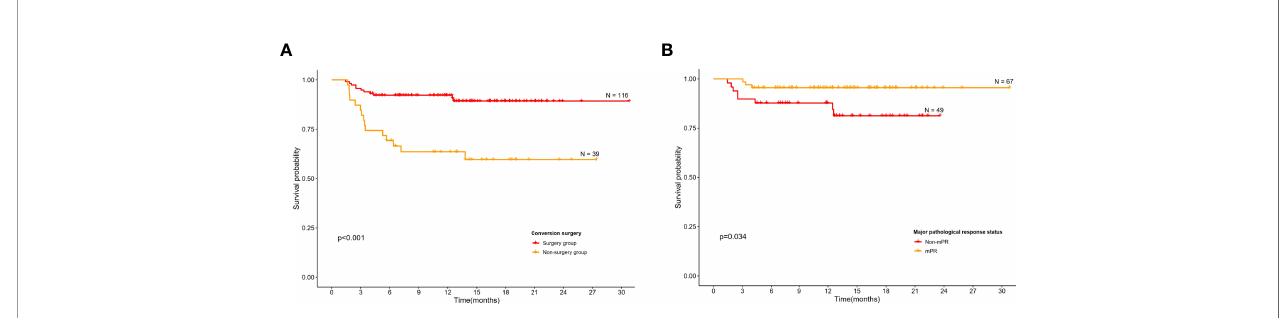
FIGURE 4 | Kaplan – Meier curves for event-free survival. (A) Conversion surgery group versus non-surgery group among all patients. (B) Event-free survival according to major pathological complete